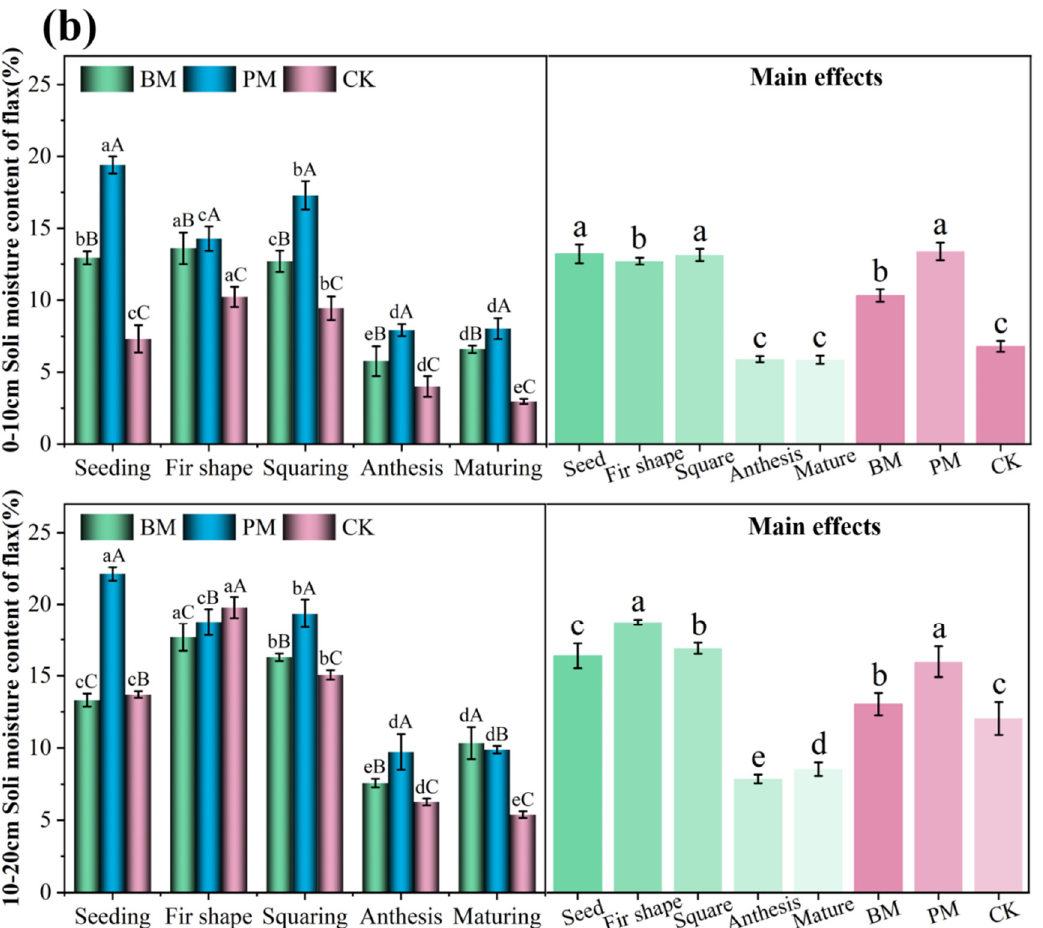
Figure 10. Soil moisture content affected by mulching materials in ( a ) maize and ( b ) flax in 2021. Soil depth was 0–10 and 10–20 cm. Values represent the mean ± standard deviation. Using Duncan’s multiple-range test, different lowercase letters indicate significant differences in soil moisture content under different mulching methods at the same growth period ( p < 0.05); different capital letters indicate significant differences in soil moisture content at different growth stages under the same mulch control ( p < 0.05). BM, biodegradable paper mulch film; PM, white plastic mulch film; CK, not covered with film.